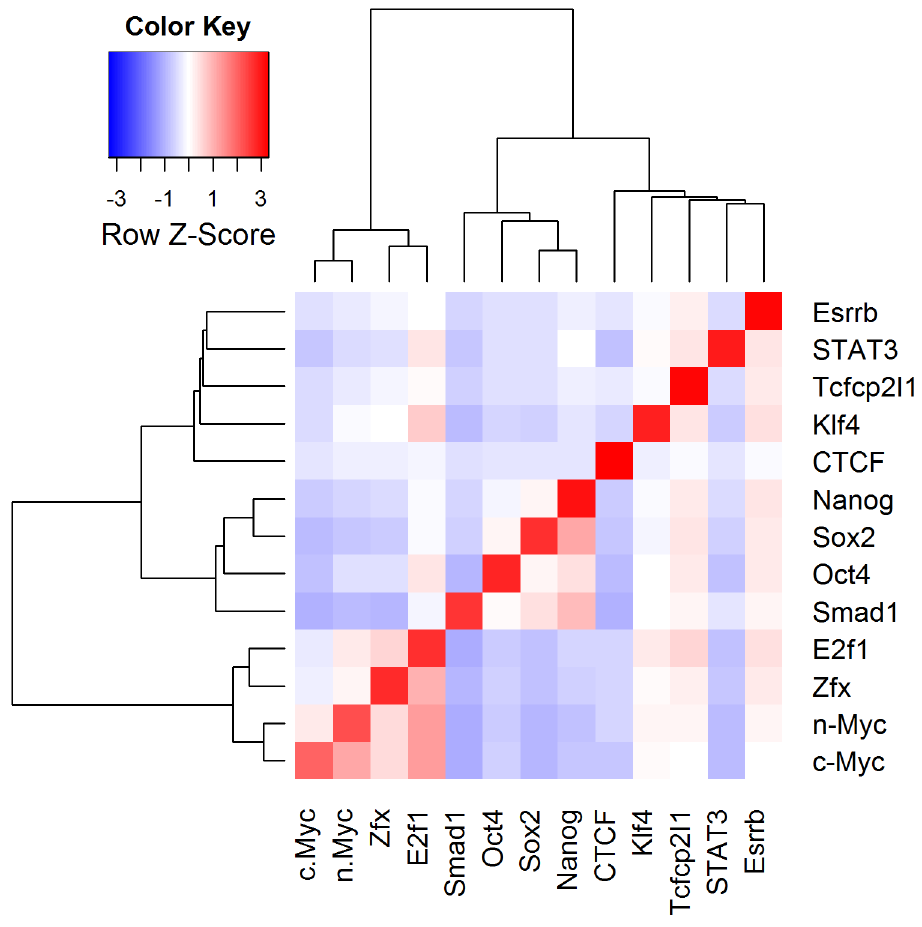
Fig 6. Overlap Based Clustering of 13 ESC Transcription Factors. Using PAPST ’ s symmetric overlap algorithm, 13 ESC Transcription were clustered. The heatmap shows the association of the 3 key reprogramming factors Oct4, Sox2, and Nanog. These groupings closely match those of Chen et al.